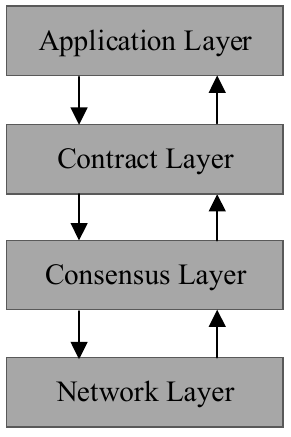
Figure 1. Layers of blockchain architecture. Adapted from Dinh, et al. [18] and Lu [17].